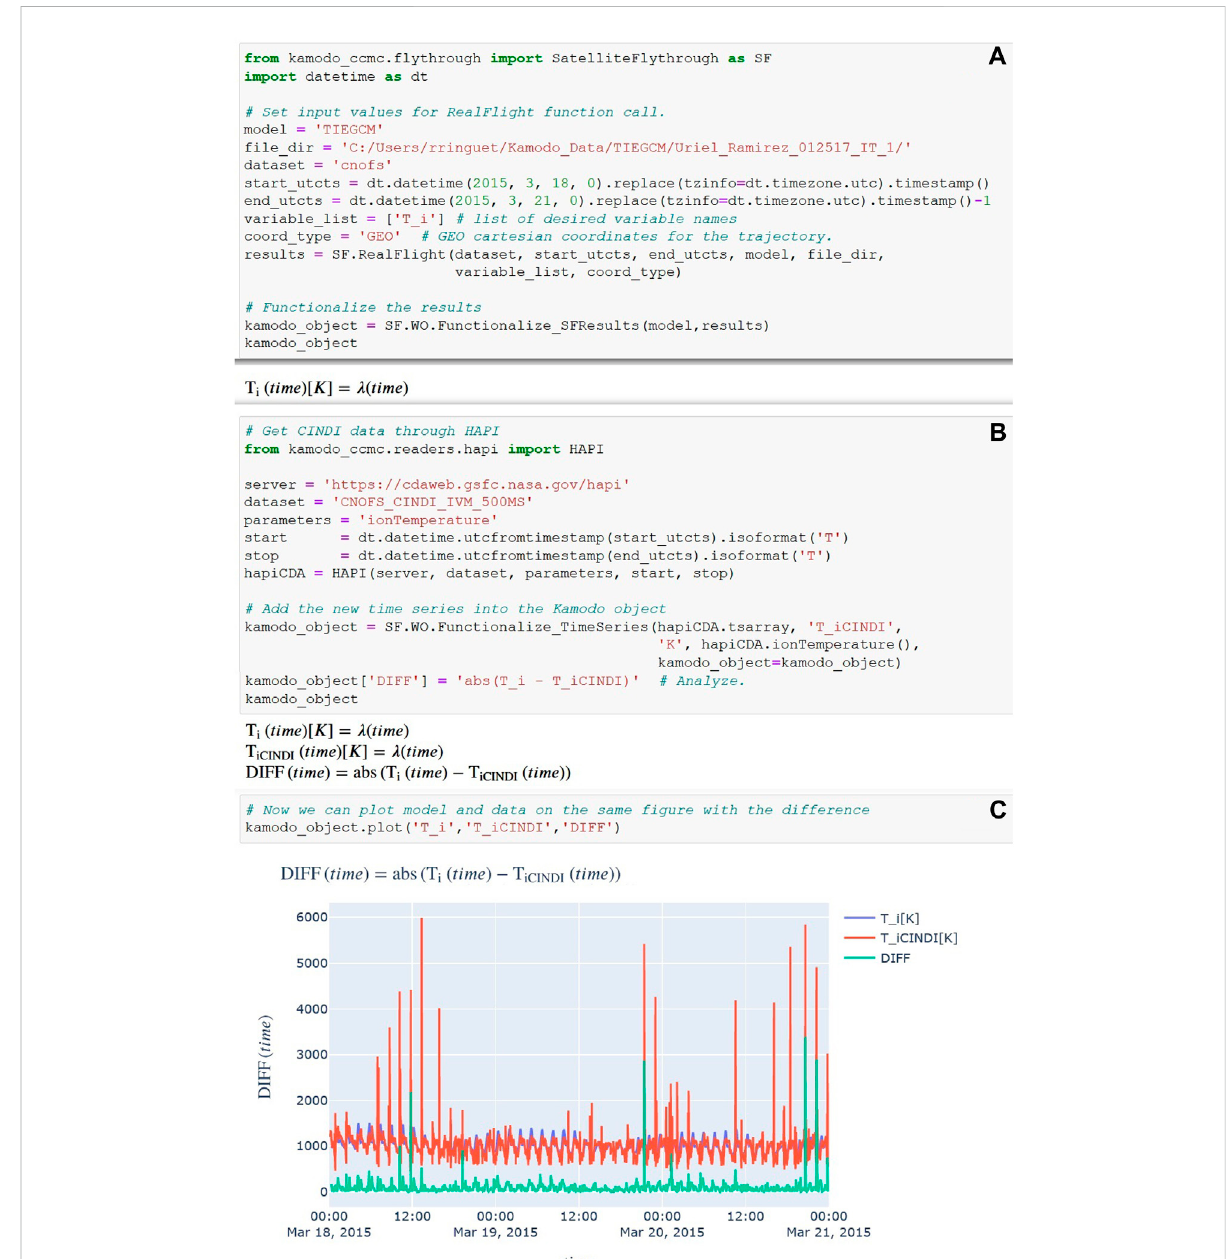
FIGURE 7 Example of model-data comparison. The fi rst block (A) uses Kamodo ’ s RealFlight function to fl y the chosen satellite trajectory through the chosen simulation output. The second block (B) retrieves the ion temperature data from the same satellite and adds it to the previously created kamodo_object variable. The difference between the two datasets is easily calculated via function composition. A fully interactive plot showing the three variables is easily created in the third block (C)